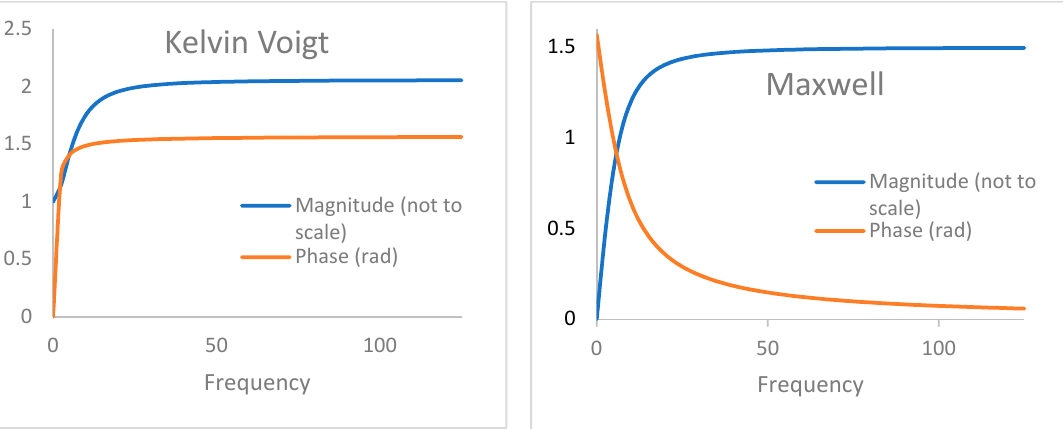
Figure 2. Bode plots of Maxwell and Kelvin Voigt systems.